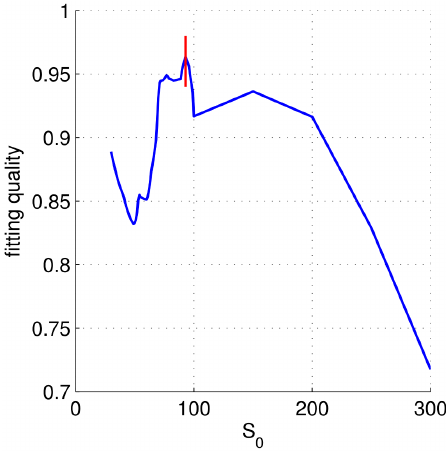
Figure 7. The selection of S (cid:2) for Gowalla. The fitting quality as function of S 0 . S (cid:2) is defined as the position (argmax) of the maximum, which is S (cid:2) ~ 93 for Gowalla.